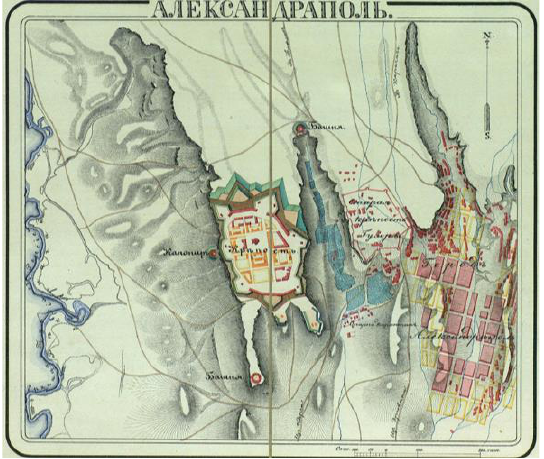
Figure 1. Plan of the fortress and town of Alexandropol, 1830s (Atlas Krepostey Rossiyskoy Imperii, s.